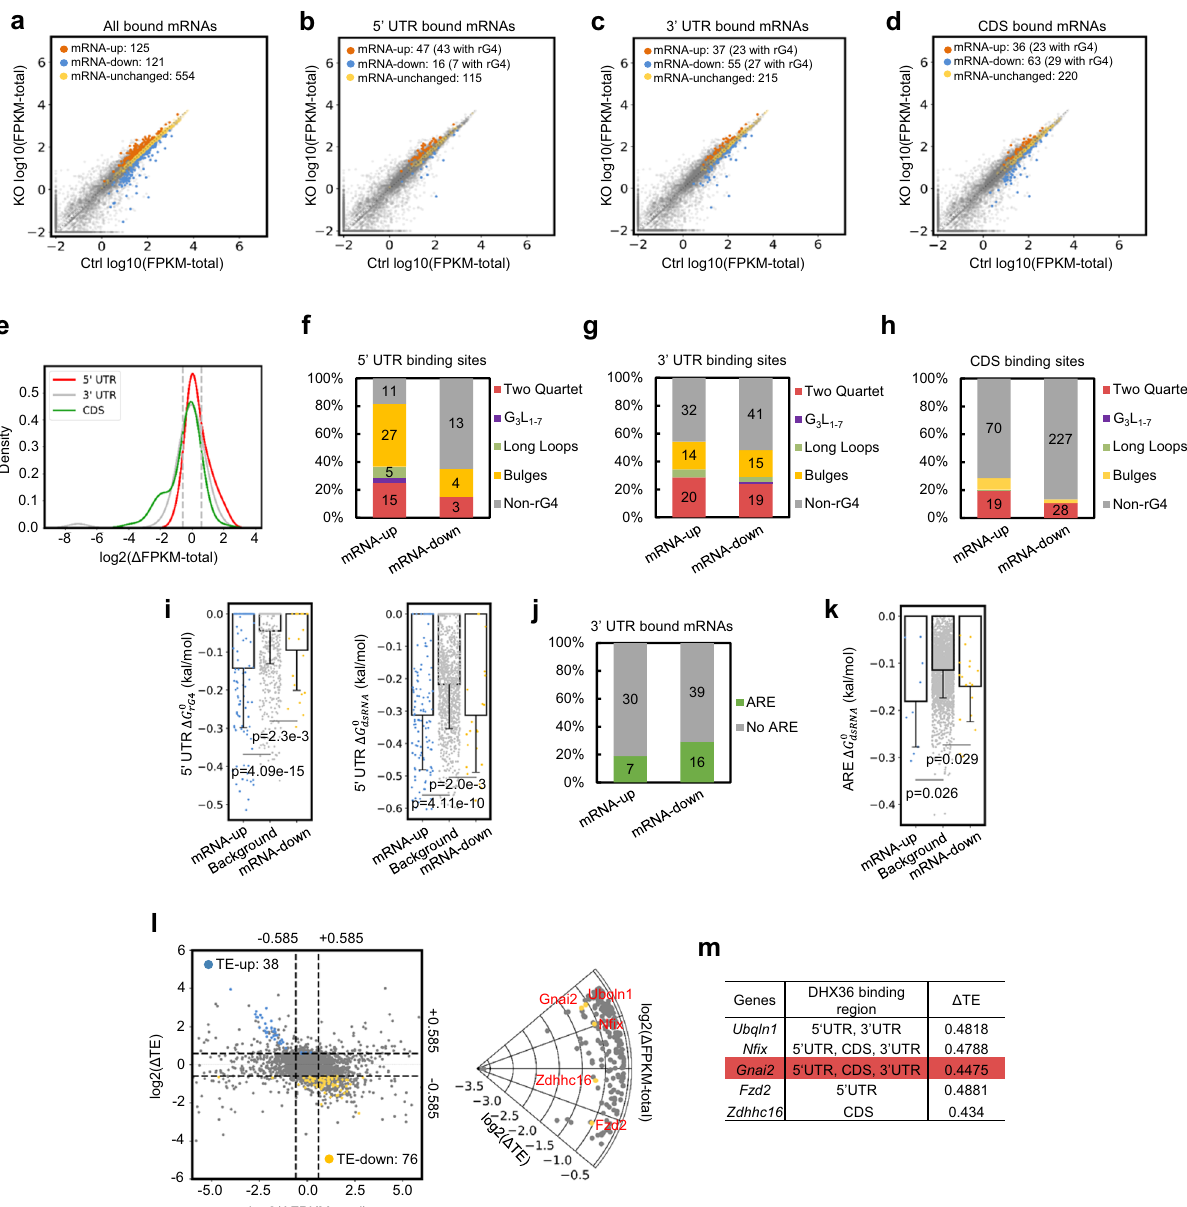
Fig. 6 Dhx36 loss exerts a potential effect on total mRNA abundance. a – d Scatterplot showing the total mRNA abundance (log10(FPKM-total)) values of all, 5 ’ UTR, 3 ’ UTR or CDS DHX36-bound mRNAs in Ctrl vs KO; the number of up- (KO vs Ctrl ≥ 1.5 fold), down-( ≤ 0.66 fold) or unchanged mRNAs are shown. e Kernel density estimates showing log2( Δ FPKM-total) values of mRNAs with DHX36 binding only in 5 ’ UTRs, 3 ’ UTRs, or CDS. Δ FPKM-total: the mRNA level alteration in KO vs Ctrl. f – h Prediction of rG4 formation in the binding sites of 5 ’ UTR, 3 ’ UTR, and CDS-bound mRNAs was conducted and the number of sites possessing each subtype is shown in up- or downregulated mRNAs. i 5 ’ UTR region predicted folding energies of rG4 and dsRNA structures in up and downregulated mRNAs with 5 ’ UTR binding, n = 116 (upregulated mRNAs), 1075 (background mRNAs), 22 (downregulated mRNAs). Data represent mean values ± s.d. j The number of 3 ’ UTR-bound mRNAs possessing ARE sites is shown. k Predicted folding energies of dsRNAs in up- or downregulated mRNAs with 3 ’ UTR ARE binding, n = 9 (upregulated mRNAs), 2499 (background mRNAs), 18 (downregulated mRNAs). Data represent mean values ± s.d. l Left: Scatterplot illustrating TE ( y axis) and mRNA ( x axis) alterations in KO vs Ctrl with a threshold of ±0.585 (dashed line) for 7300 genes with FPKM-total values larger than 1 in either Ctrl or KO condition. Blue dots: TE-up genes with DHX36 binding; yellow dots: TE-down genes with DHX36 binding. Gray dots: the genes with no signi fi cant TE change or no DHX36 binding. Right: A total of fi ve bound genes (yellow dots) including Ubq1n1, N fi x, Gnai2, Fzd2 , and Zdhhc16 (red font) showed constant mRNA and decreased TE levels in KO vs Ctrl using a more stringent threshold (log2( Δ TE) < − 1, Δ TE<0.5). Gray dots: 197 genes with signi fi cant TE decrease and constant mRNA levels but with no DHX36 binding. m DHX36 binding regions and Δ TE values are shown for the fi ve genes in panel l and Gnai2 is highlighted. One-tailed Mann – Whitney test was used to calculate the statistical signi fi cance between folding energy values in panels i and k with P values shown in the fi